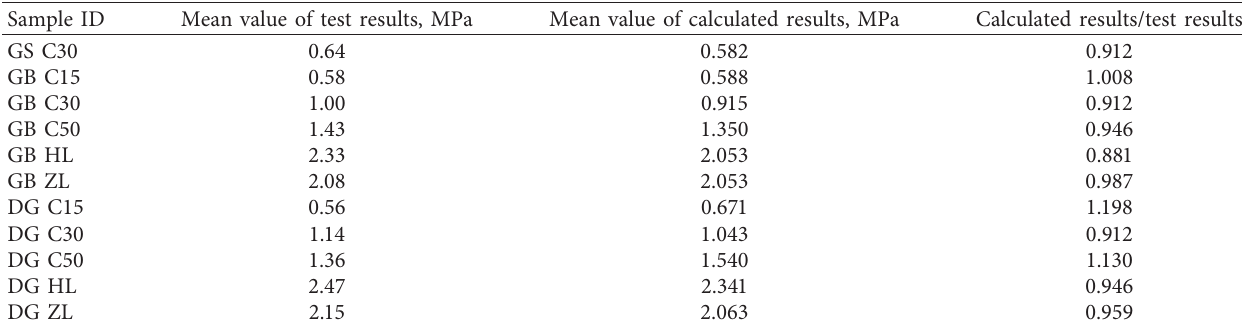
Table 12: Comparisons between calculated and test shear strength.